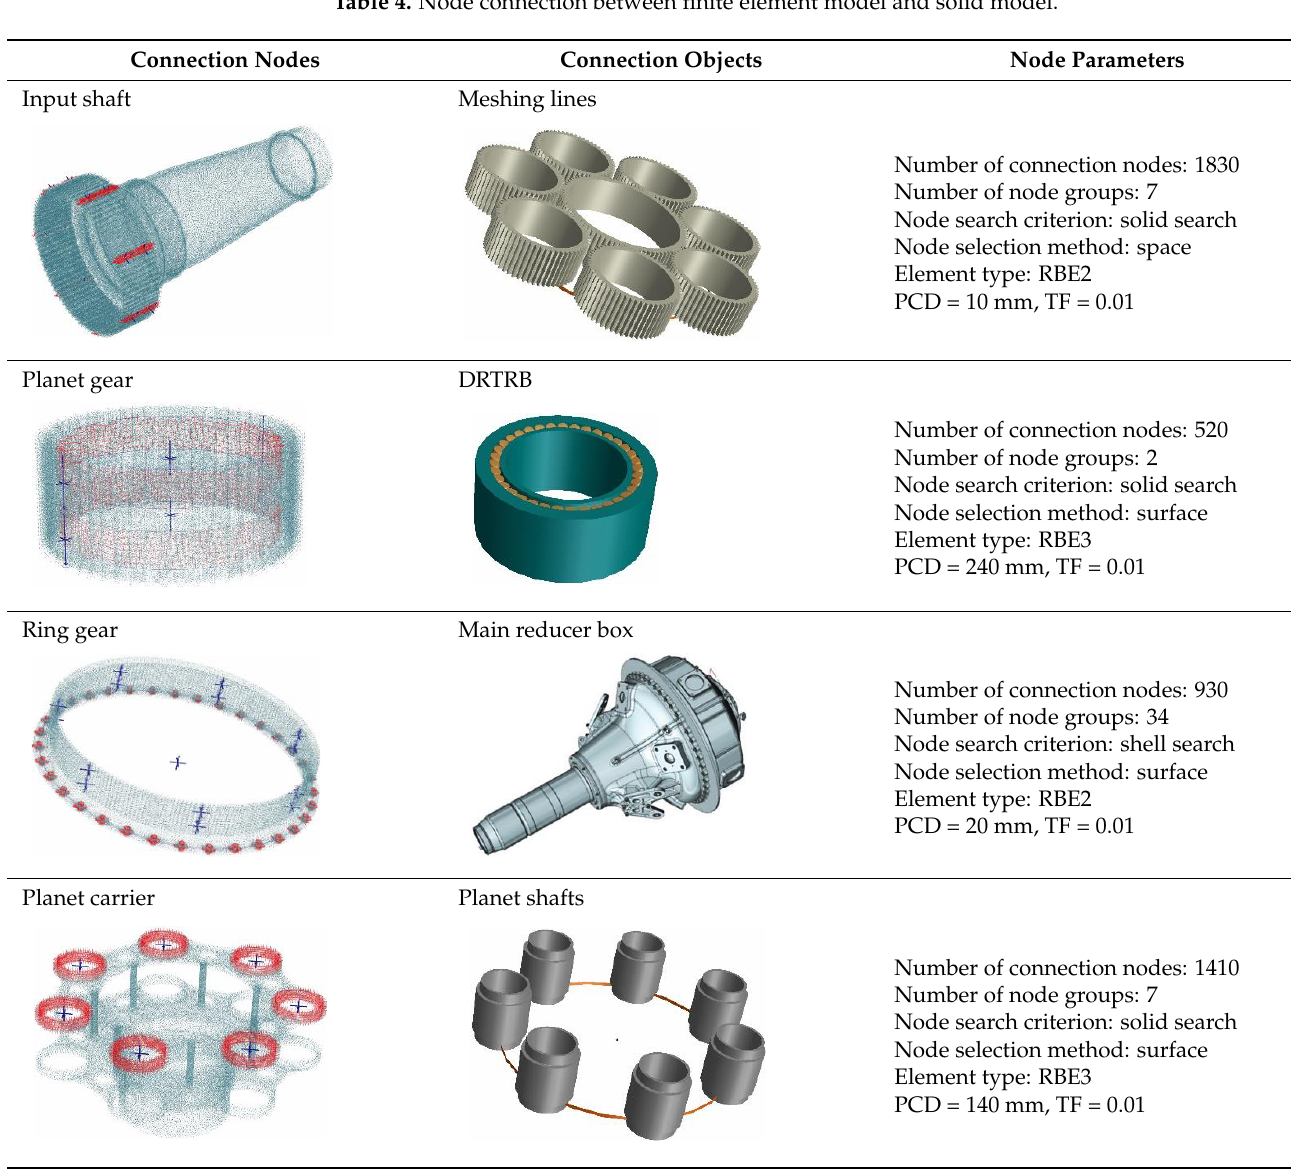
Table 4. Node connection between finite element model and solid model.